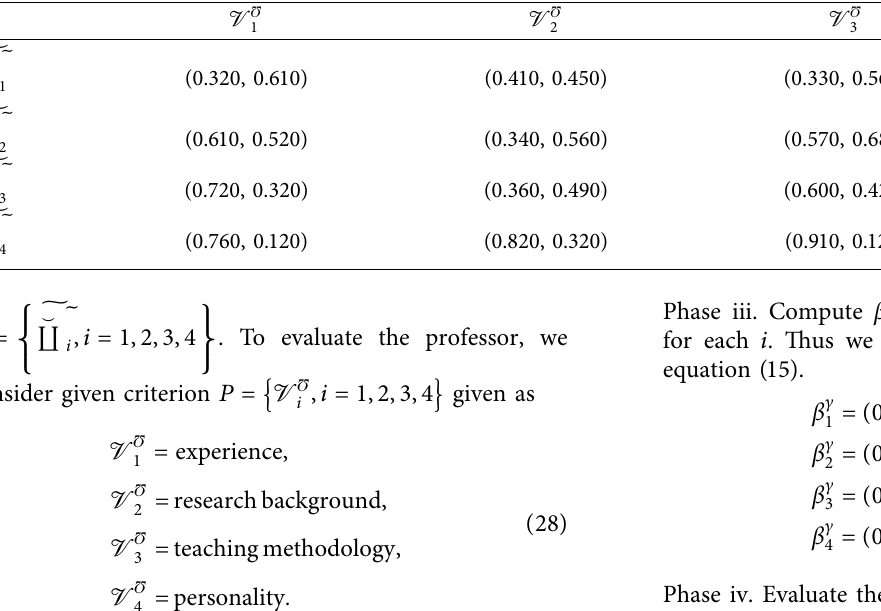
for the collective i